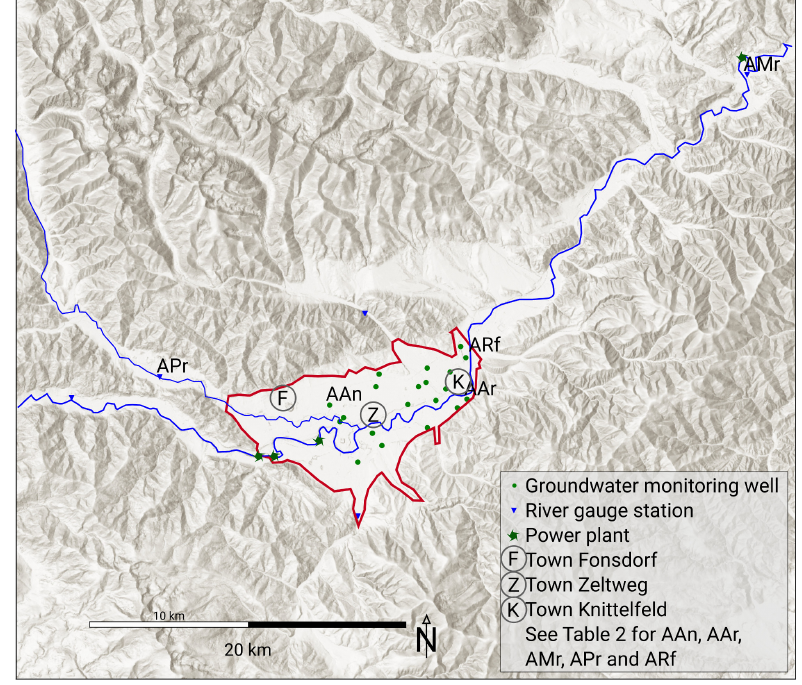
Figure B1. Detailed map for the Aichfeld subregion